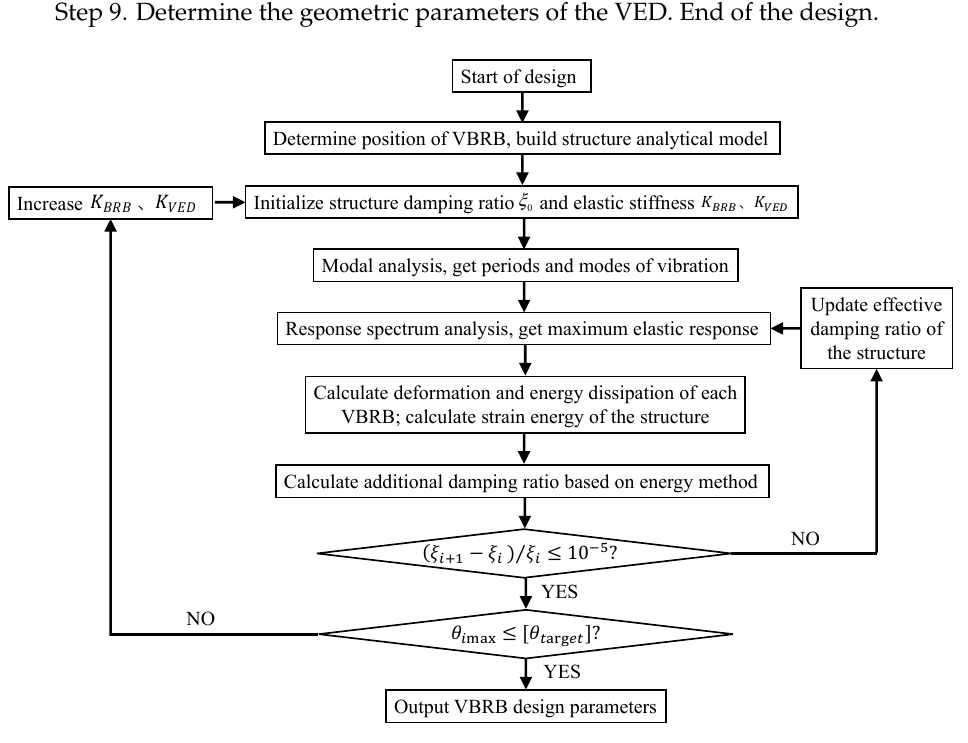
Figure 6. Parametric design procedures for VBRB-equipped structures.